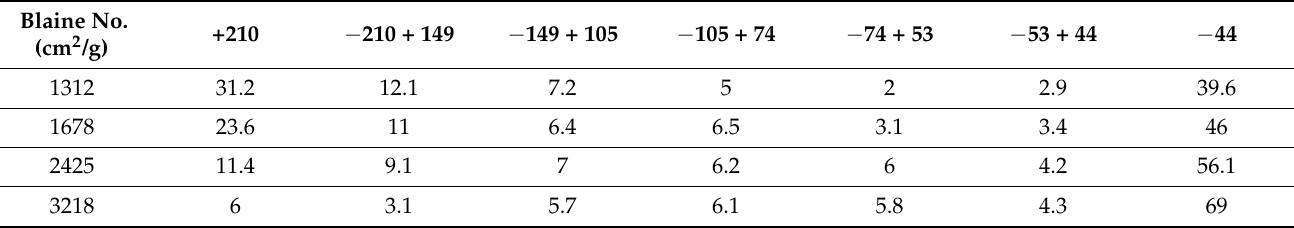
Table 1. Size fraction of (Iron Ore No.1) iron ore used size ( µ m).